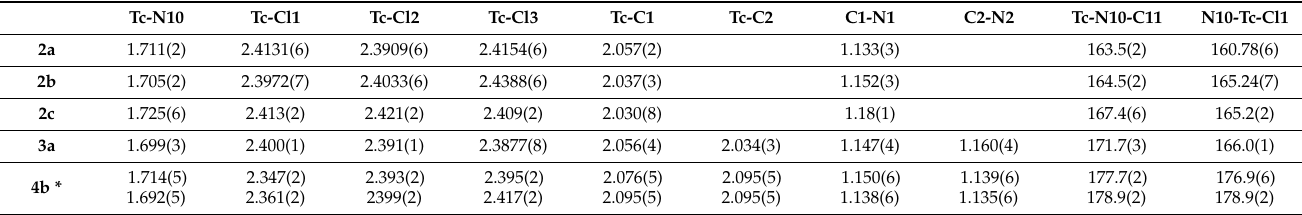
Table 2. Selected bond lengths (Å) and angles (°) for [Tc(NPh)Cl 3 (PPh 3 )(CN t Bu)] ( 2a ), [Tc(NPh)Cl 3 (PPh 3 )(CNMes)] ( 2b ), [Tc(NPh)Cl 3 (PPh 3 )(CNPh i-prop2 )] ( 2c ), cis -[Tc(NPh)Cl 3 (CNAr Mes2 ) 2